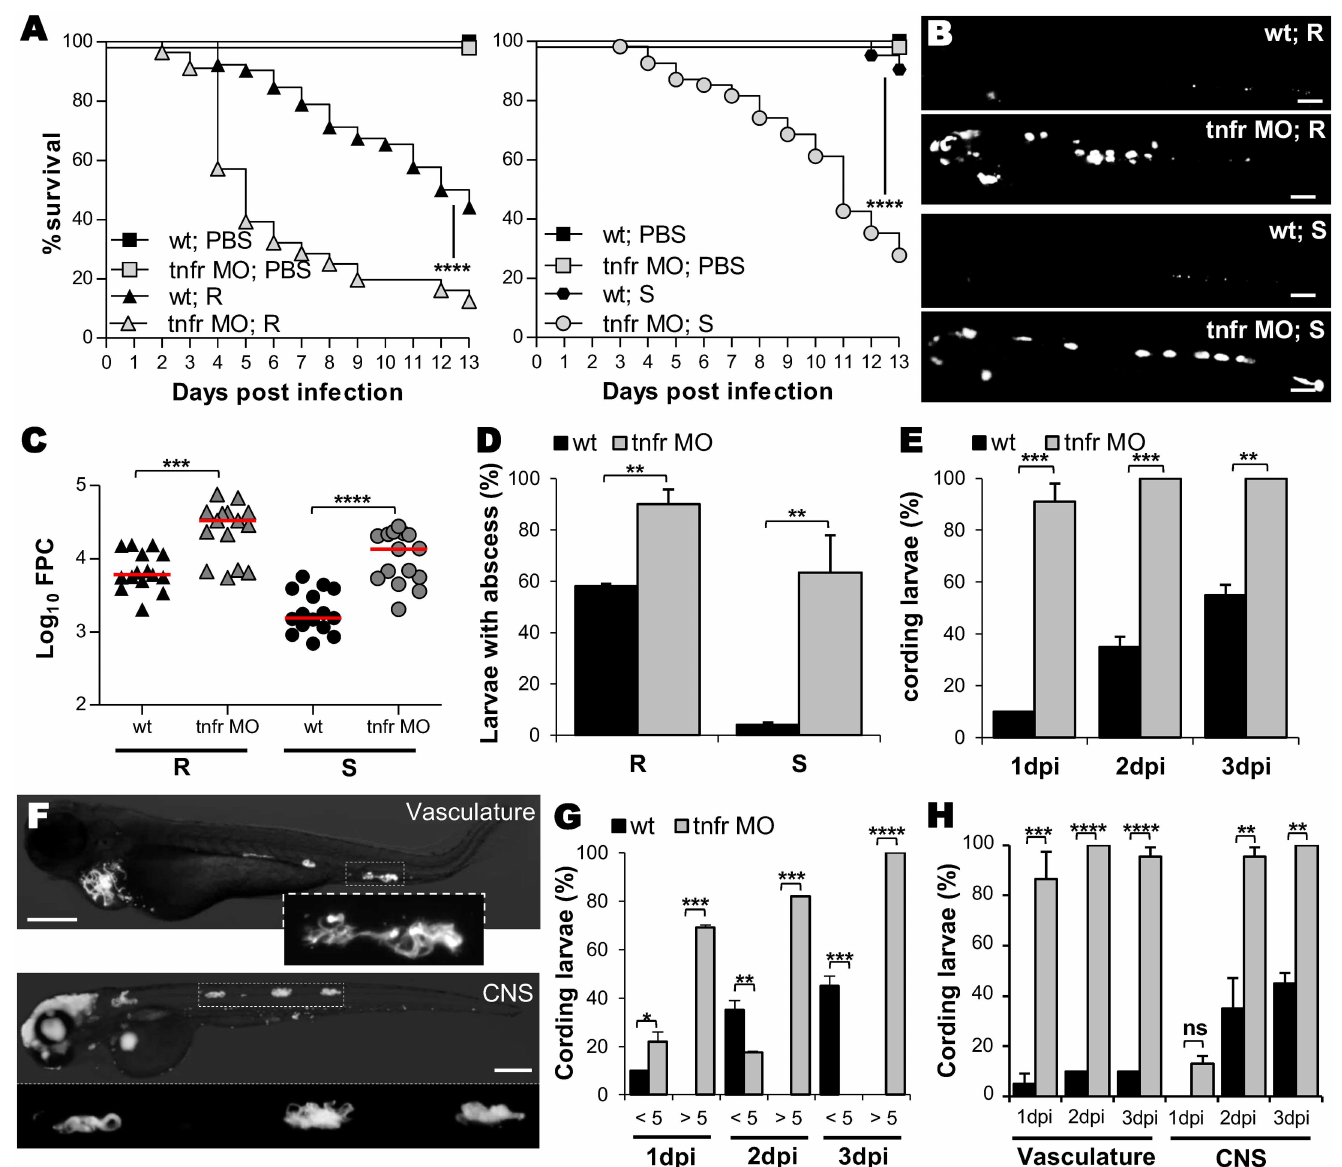
Fig 2. tnfr morphants are highly susceptible to Mabs infections. (A-H) WT or tnfr morphants were iv infected with either R (A-H) or S (A-D) variants of Mabs (tdTomato, (cid:25) 150 CFU). (A) Survival of infected embryos versus PBS-injected embryos (n = 90, average of three independent experiments). (B-C) Representative fluorescenceimages of: (B) Bacterial loads (FPC, two independent experiments, horizontallines indicate the median values); (C) 3 dpi embryos infected by either R or S variants. Scale bars, 200 μ m. (D) Proportion of larvae with abscesses after 13 dpi expressed as mean ± SEM from two independent experiments (n = 40–50). (E) Kinetic of R-cord formation in whole infected embryos. Mean ± SEM from three independent experiments (n = 30). (F) Fluorescencemicroscopy of tnfr morphants exhibitingwidespread R-cordingin the vasculatureand in the CNS at 3 dpi. Scale bar, 200 μ m. (G-H) Proportion of embryos containing < 5 or > 5 cords (G) and localization of cords (H) in (E). Error bars represent the SEM. Statistical significance was determined by log-rank test (A), one-tailedMann-Whitney’s t test (C) or Fisher’s exact test of a contingency table (D-E and